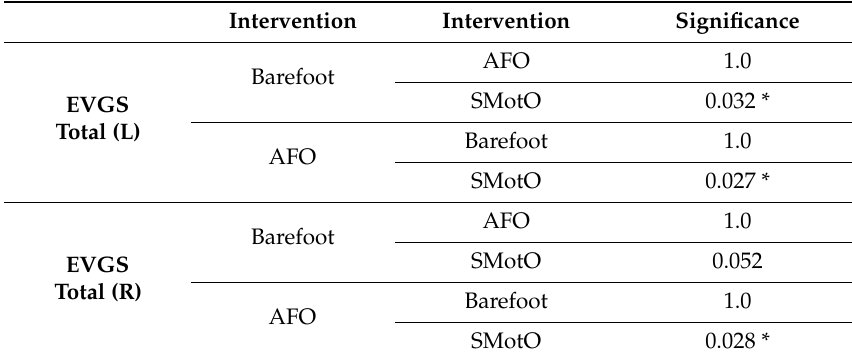
Table 4. Bonferroni comparison between the three